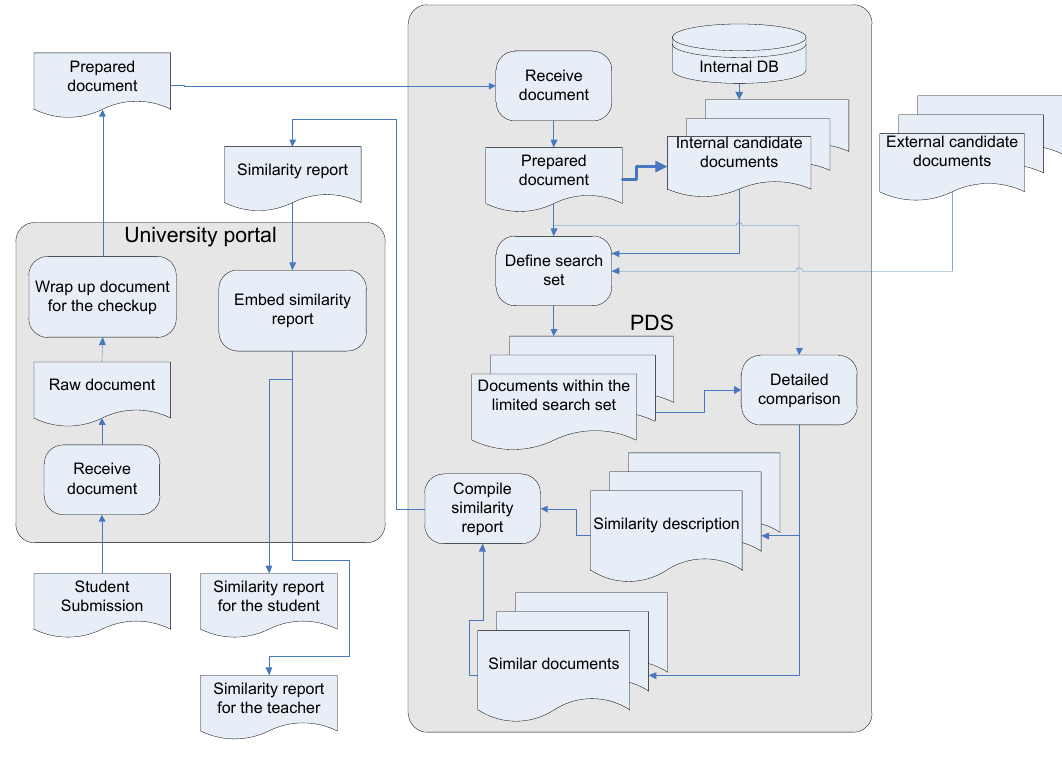
Figure 2 . The complete outsourcing of the plagiarism detection process. As illustrated by this example, from the IP protection point of view, using an external ser- vice to only narrow down the search scope is better than outsourcing the whole detection process because student submissions will not be stored and reused for profit. But there is still a concern because the suspicious submission goes to the third party. From a legal standpoint, some suggested using only a limited amount of information from the suspi - cious text to obtain potential sources from the Web (Butakov & Barber, 2012), but this left an open question about how such selection would affect the detection quality. Referring back to Figure 1, this approach means that the external PDS should not keep the submitted document and should not get it in its original form. The next section outlines the details of the architecture based on these principles and can serve as a blueprint for this sort of PDS